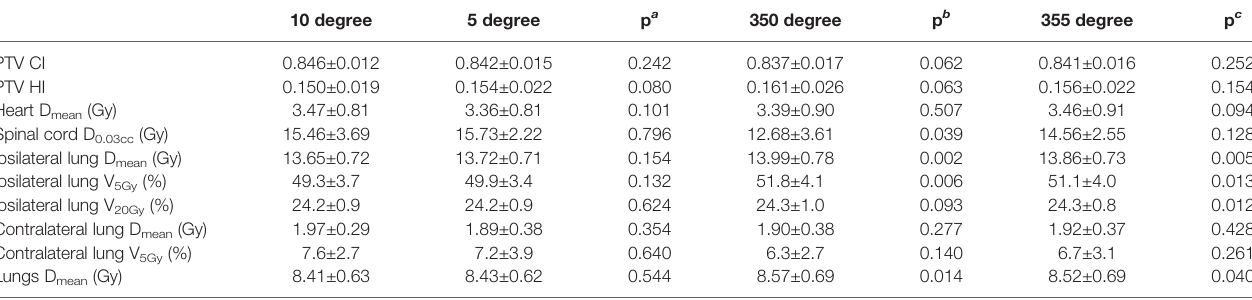
TABLE 6 | Dosimetric results (mean ± standard deviation) of right-sided postmastectomy VMAT plans with different collimation angles.